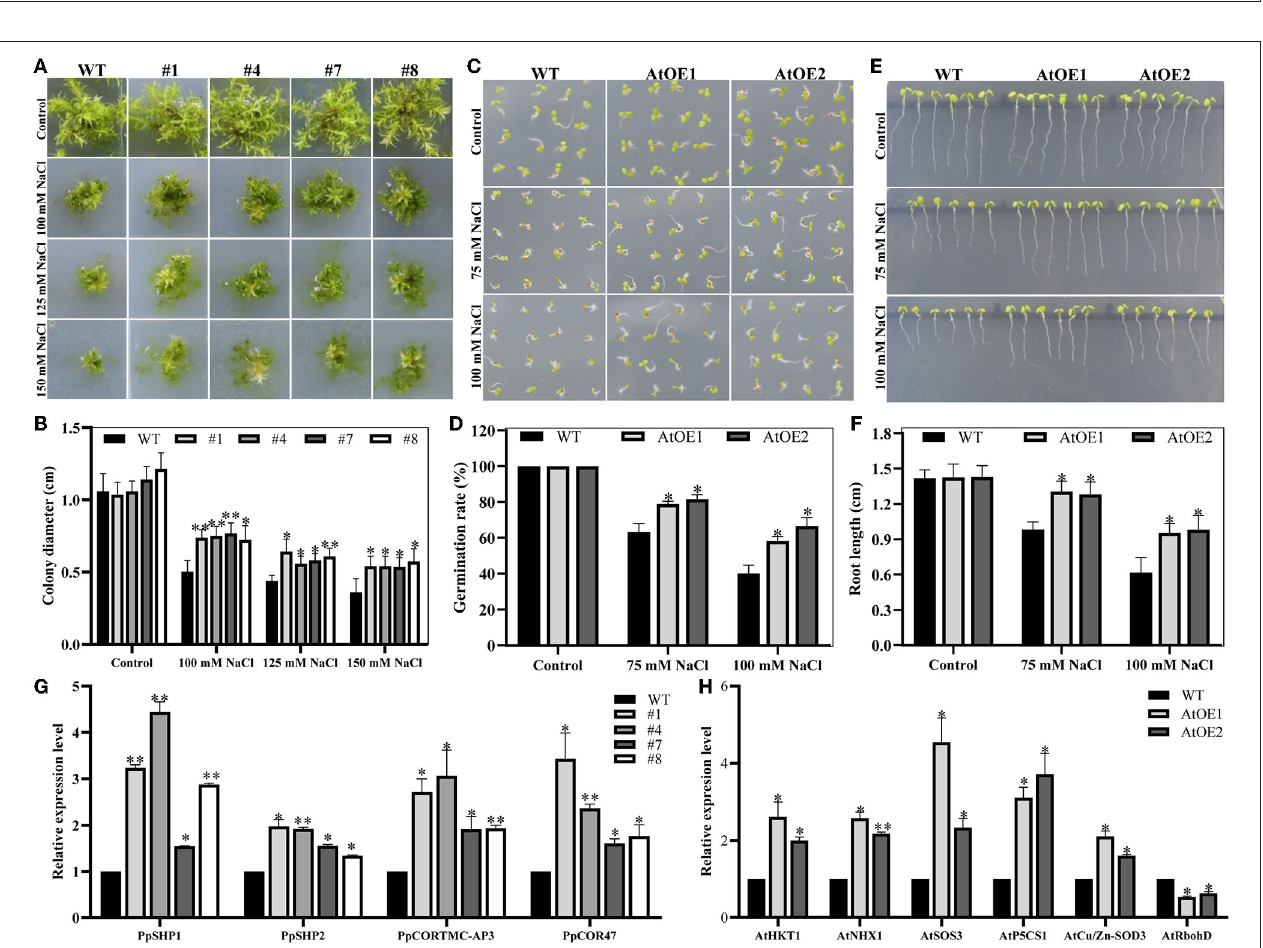
FIGURE 5 | Heterologous expression of Pn2-ODD1 enhanced plant resistance to salt stress. (A) The transgenic P. patens displayed larger gametophytes than the WT plants under NaCl treatment. (B) Statistical analysis of gametophyte size as shown in (A) . (C,E) AtOE lines exhibited higher germination rates and longer root length in contrast with WT plants under salt stress. (D,F) Statistical analysis of the seed germination rates and root length as shown in (C,E) . (G,H) Expression patterns of stress-responsive genes in Pn2-ODD1 transgenic P. patens and Arabidopsis measured by qRT-PCR. Asterisk (*) represents a significant difference between the WT plants and AtOE lines (Student’s t -test, * P < 0.05, ** P <